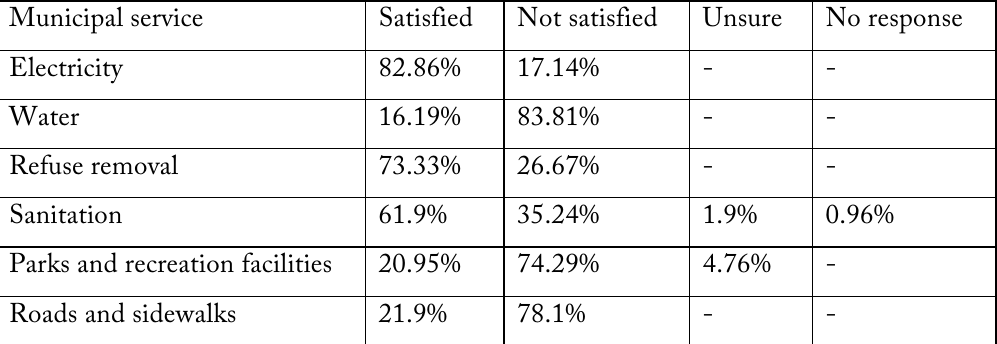
Table 7: Levels of satisfaction regarding municipal services amongst participants Municipal service Satisfied Not satisfied Unsure No response Electricity 82.86% 17.14% - - Water 16.19% 83.81% - - Refuse removal 73.33% - - Sanitation 61.9%